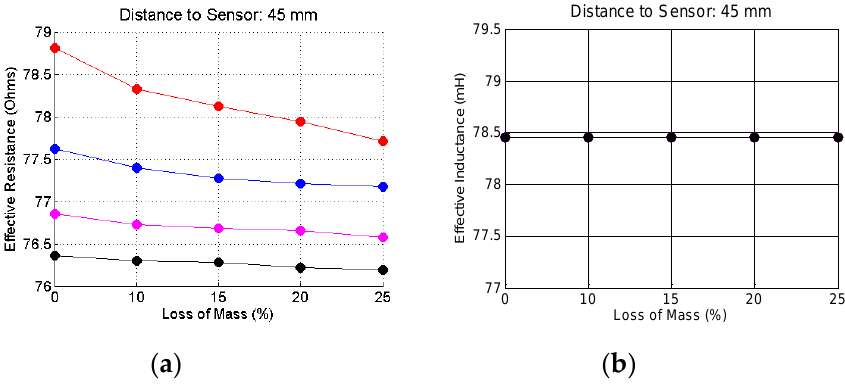
Figure 17. Resistance ( a ) and inductance ( b ) for the steel bars at the reference distance of 45 mm.